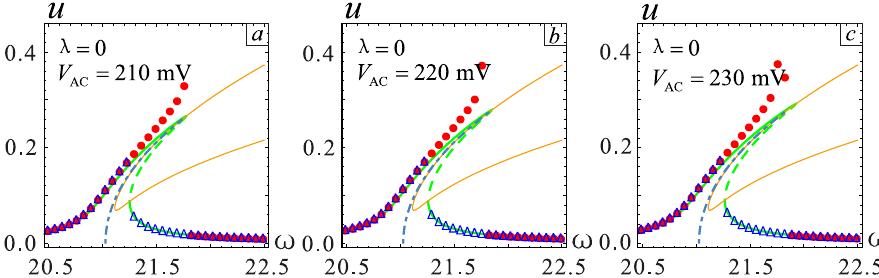
Figure 8. The changes in frequency response as AC voltage increases at λ = 0. ( a ) is the case of V AC = 210 mV. ( b ) is the case of V AC = 220 mV. ( c ) is the case of V AC = 230 mV. The solid lines represent stable solutions. The dashed lines represent unstable solutions. The point represents the numerical solution.